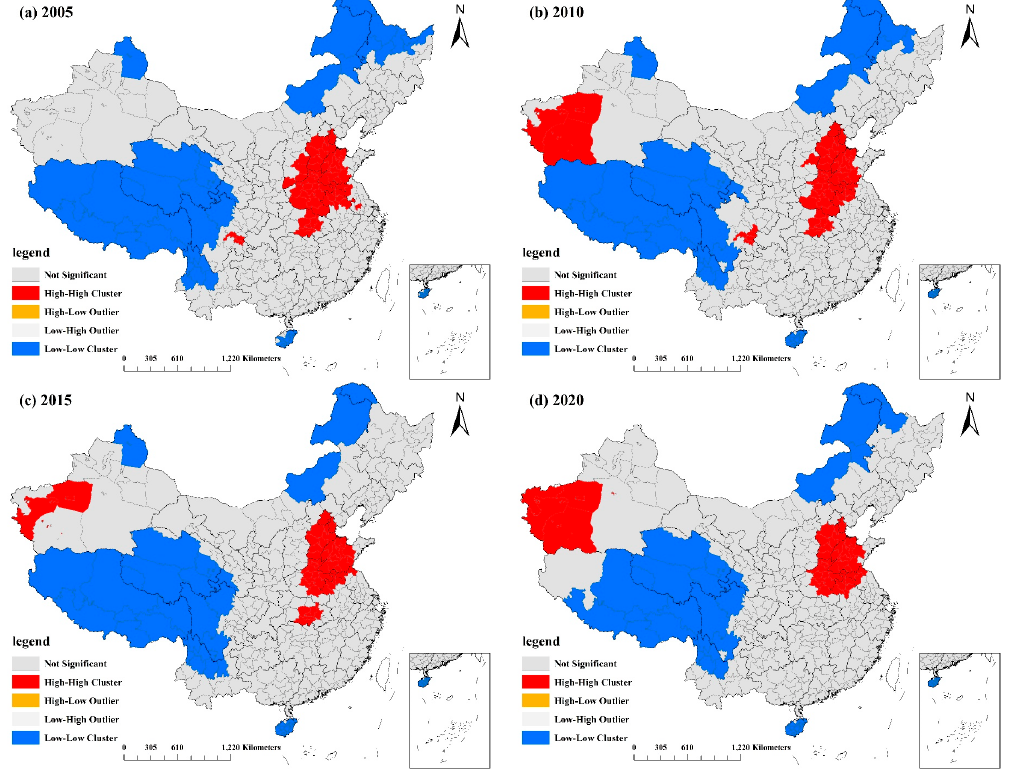
Figure 3. Spatial clustering of annual average PM2.5 concentration values in China from 2005 to 2020: ( a ) spatial clustering of annual average PM2.5 concentration values in 2005; ( b ) spatial clustering of annual average PM2.5 concentration values in 2010; ( c ) spatial clustering of annual average PM2.5 concentration values in 2015; ( d ) spatial clustering of annual average PM2.5 concentration values in